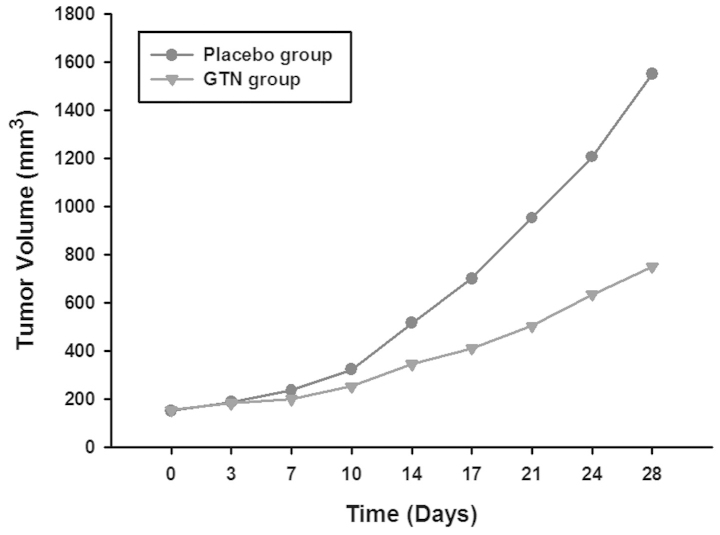
Tumor growth of the GTN and placebo groups. Tumor volume was monitored every 3–4 days. With increasing treatment time, the tumors of the GTN group were markedly smaller compared with those of the placebo group. GTN, glyceryl trinitrate.